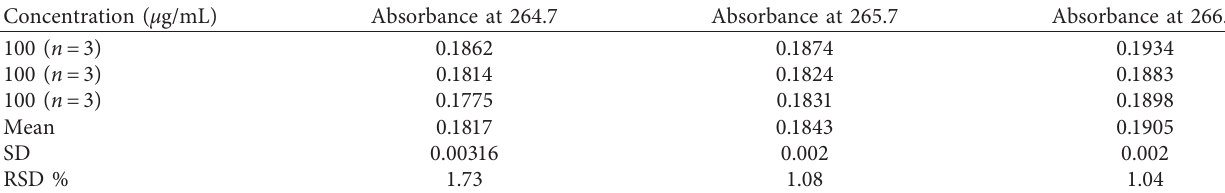
Table 7: Robustness data of SRP.